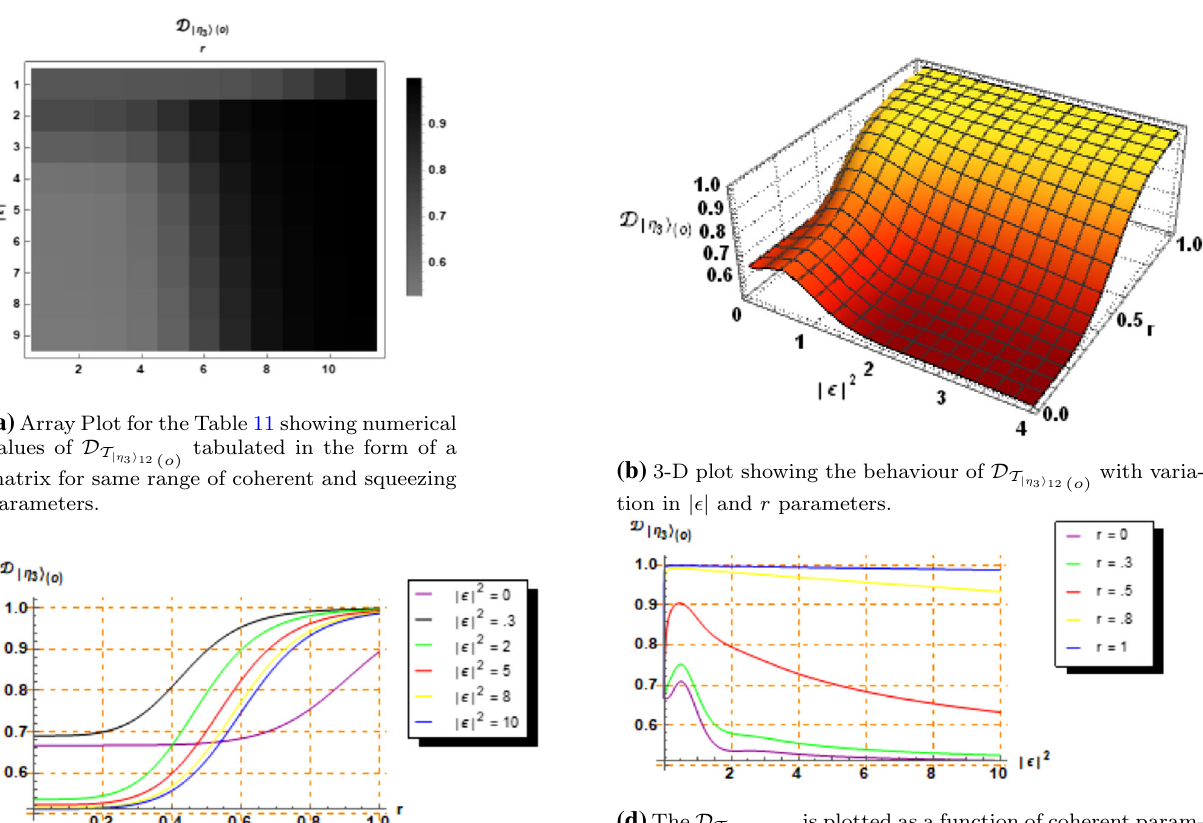
(b) 3-D plot showing the behaviour of tion in | (cid:2) | and r parameters.